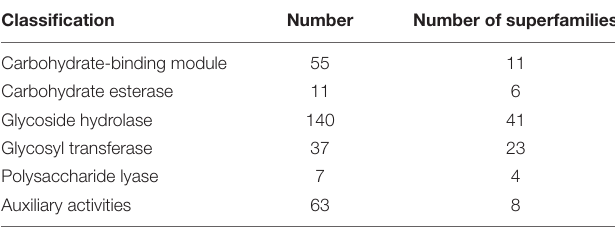
TABLE 3 | Carbohydrate-active enzyme annotation results.